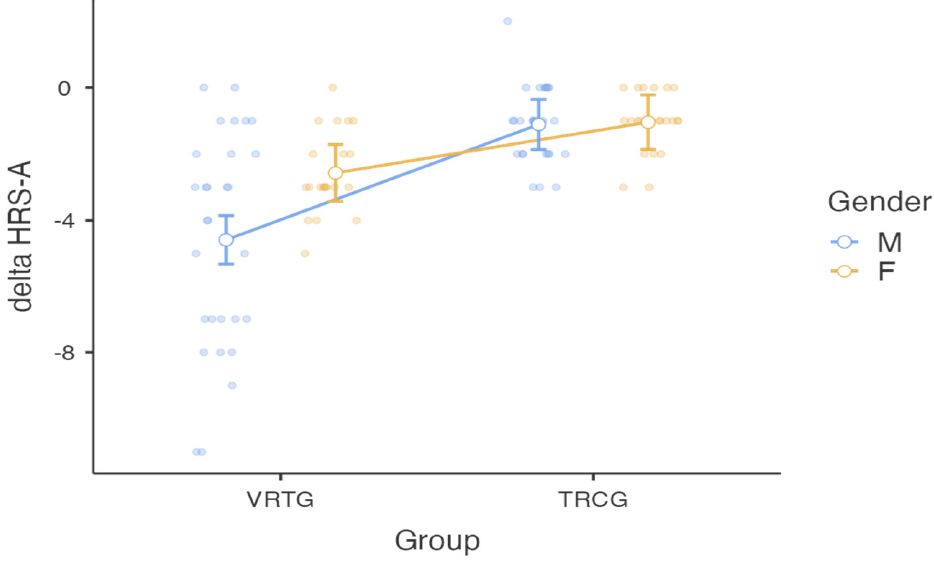
Figure 2. Interaction effect Group × Gender for the HRS-A scores. Behavioral changes before and after treatment were calculated as the delta-value. Traditional Rehabilitation Control Group: TRGC; Virtual Reality Training Group: VRTG.